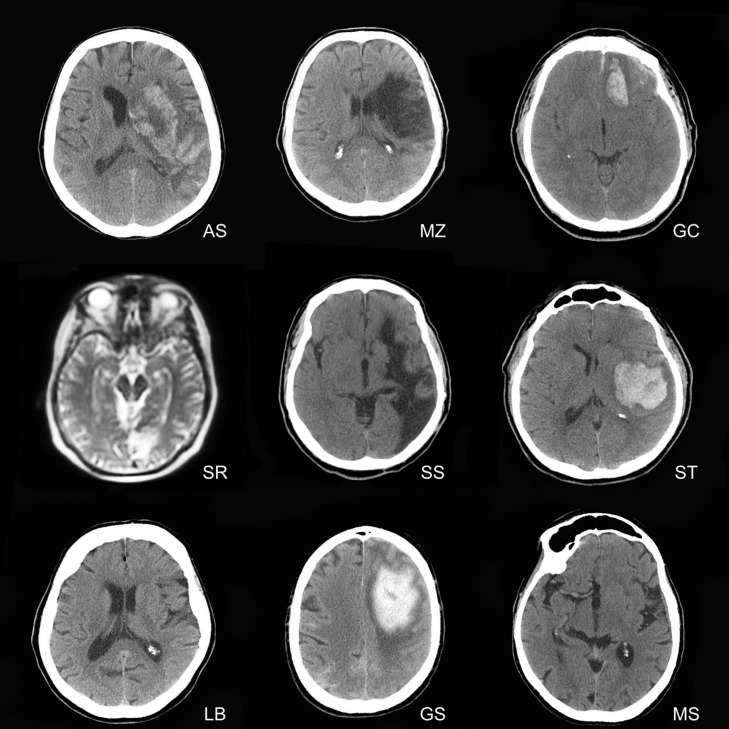
Magnetic resonance imaging and Computed Tomography scans of right hemisphere-damaged patients. The right hemisphere is displayed on the right in each brain scan.